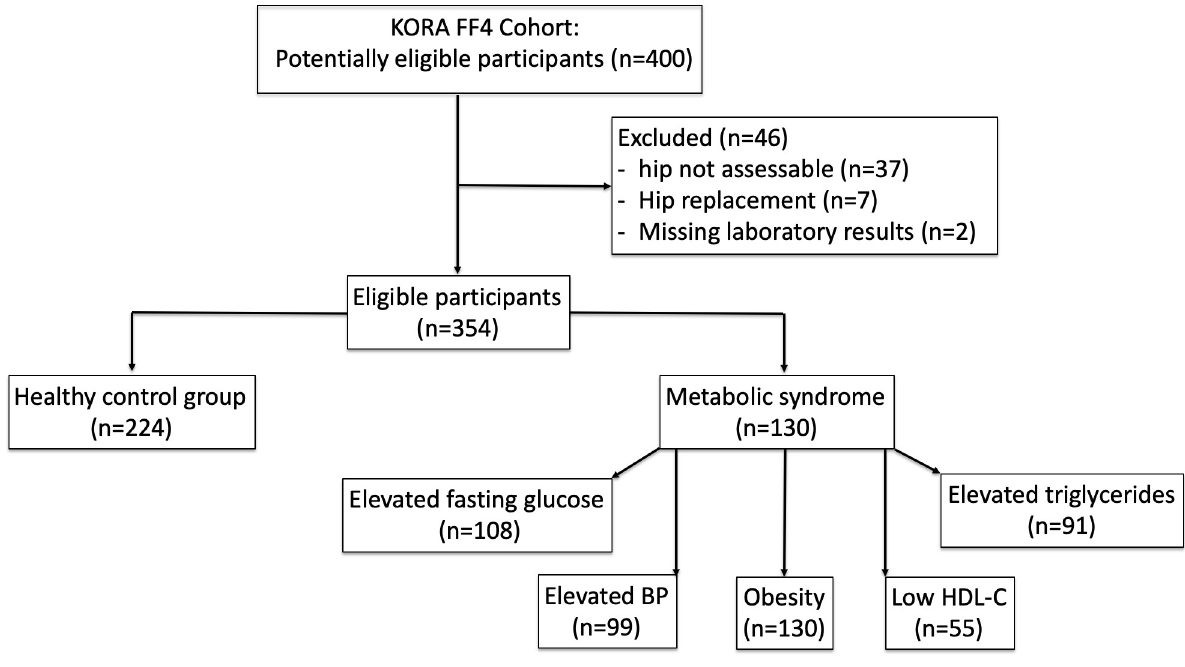
Fig 2. Inclusion flow